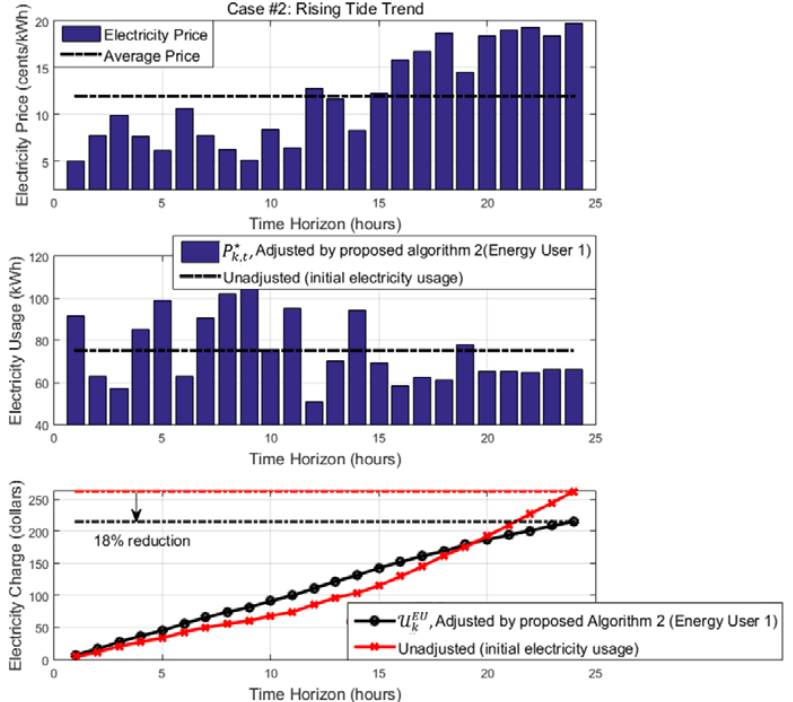
Figure 6. Electricity price with time (Case #2: rising-tide trend) and the electricity usage adjusted accordingly, and the confirmation of the electricity-charge saving.